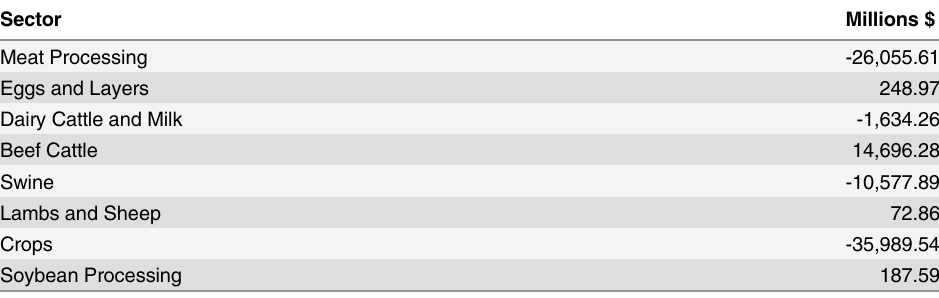
Table 7. Changes in Aggregate Producer Returns to Capital and Management for Liquid Waste Event, P50/P50